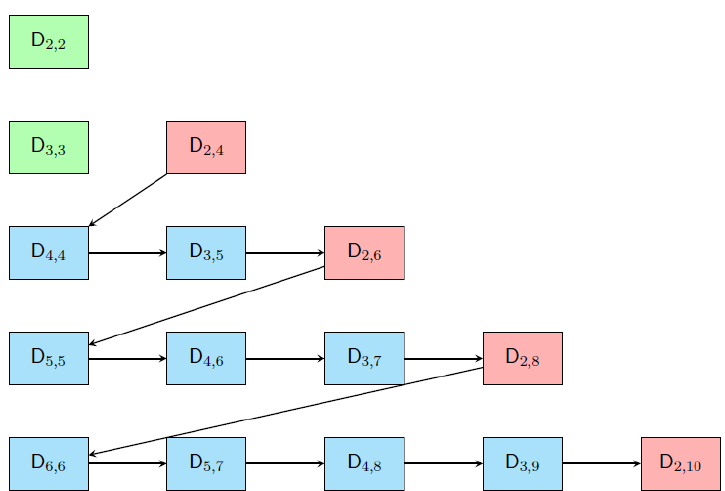
Figure 2 . The sequence of steps that allow us to deduce the strong coupling expansions of D k,‘ starting from those of D 2 , 2 and D 3 , 3 that are obtained using the results of [23] and are given in (B.2). In blue we have indicated the entries that can be completely determined using the information obtained in the preceding steps of the procedure, while in red we have indicated the elements that at each level introduce a new free